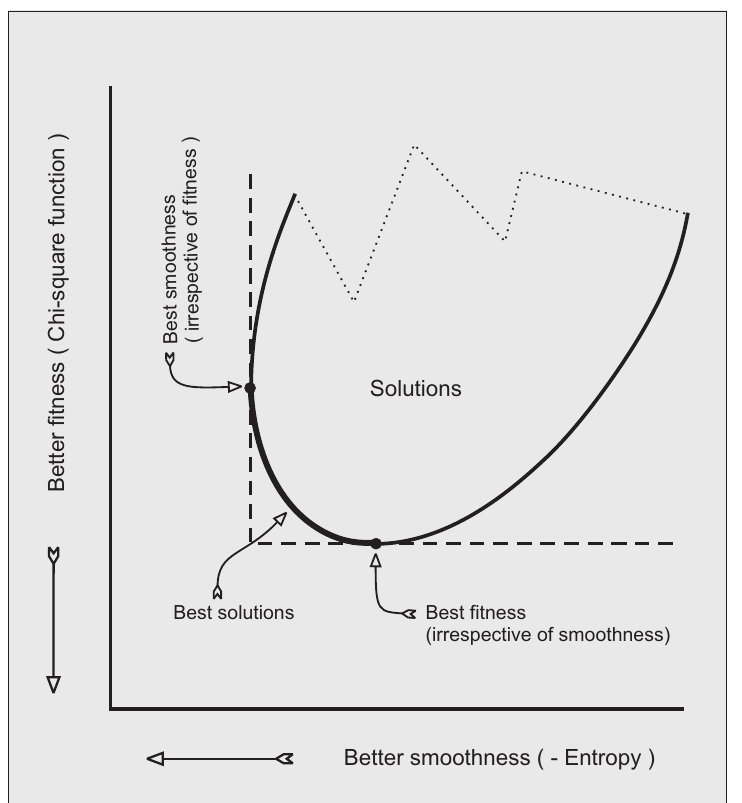
Figure 5. Trade-off between entropy maximization and chi-square